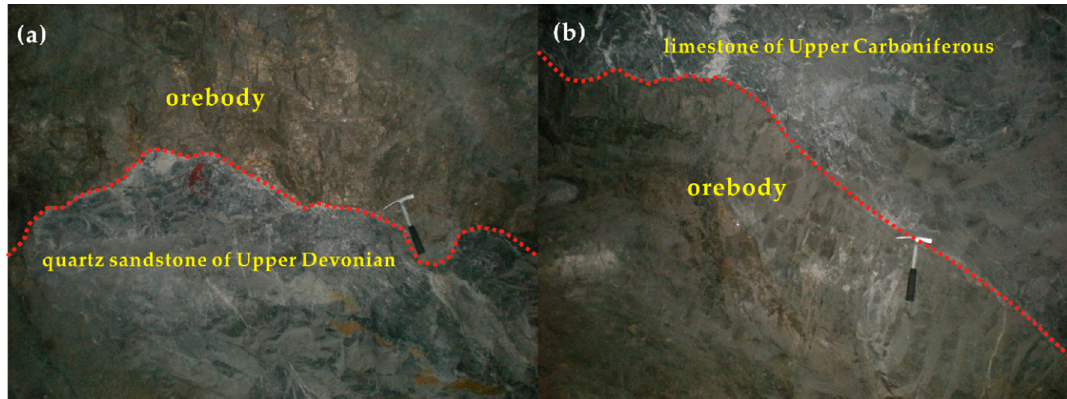
Figure 22. Photographs showing the discordant boundaries between stratiform orebodies and wall rocks in the Xinqiao deposit. ( a ) the boundary between orebody and underlying Upper Devonian quartz sandstone; and ( b ) the boundary between orebody and overlying Upper Carboniferous limestone.